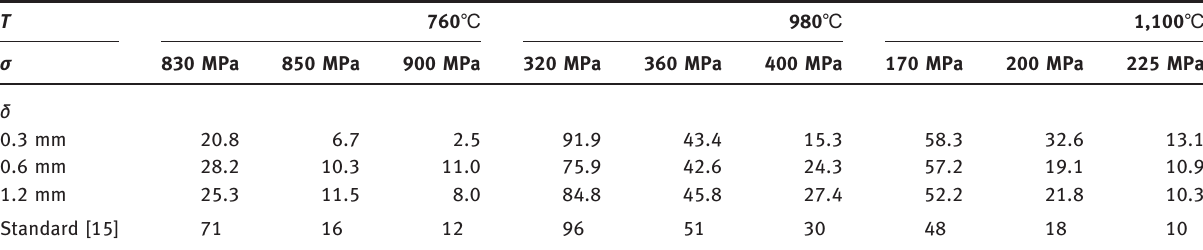
Table 2: The average creep life of thin-wall specimens in this creep test (h).